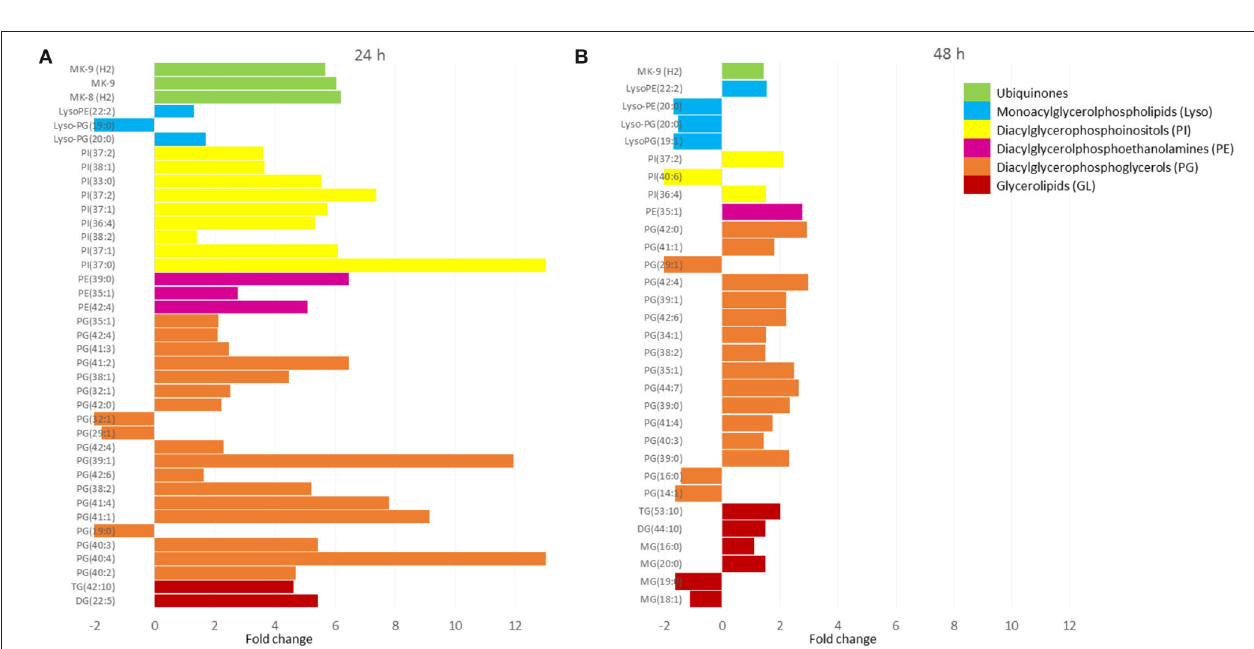
FIGURE 3 | The lipid profiles of bacteria after 24h (A) and 48h (B) exposure to propolis. The m/z values of features were assigned to singly protonated ions (M + H) + or (M + Na) + with an allowed 0.05 m/z mass difference. Only statistically significantly changed features were annotated. The molecular features present in propolis extract were removed from test samples. X-axis values correspond to the fold change observed for annotated lipids, which were grouped in classes (different colors). Values above zero represent upregulation, while below zero downregulation. MG, monoacylglycerols; DG, diacylglycerols; TG, triacylglycerols; PG, diacylglycerophosphoglycerols; PE, diacylglycerophosphoethanolamines; PI, diacylglycerophosphoinositols; Lyso-GP, monoacylglycerophosphoglycerols; Lyso-PE, monoacylglycerolphosphoethanolamines; MK, menaquinones.